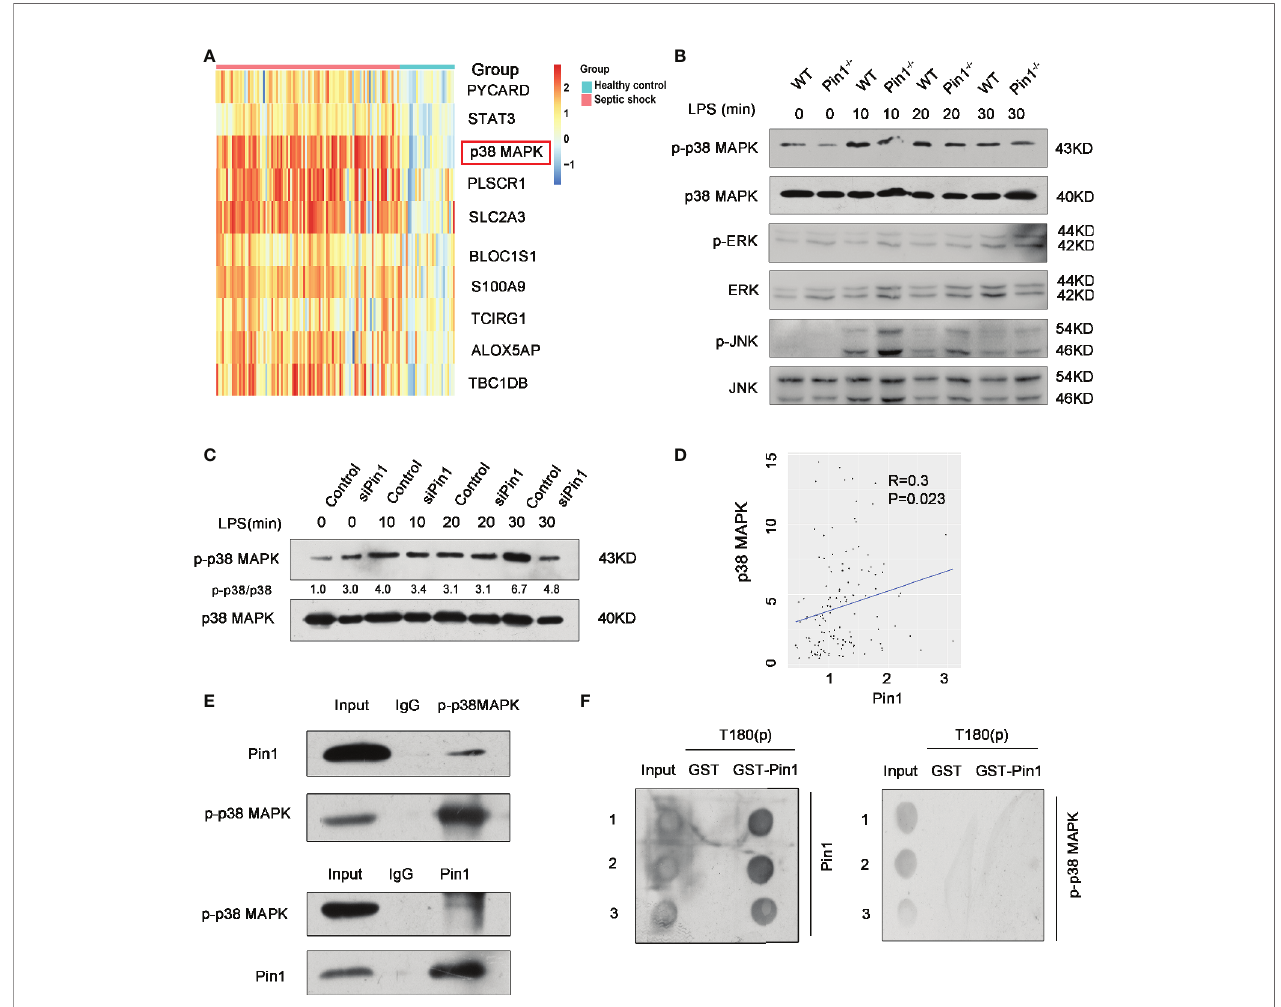
FIGURE 5 | Pin1 regulates NLRP3 in fl ammasome expression by promoting phosphorylation of p38 MAPK pathway. (A) Analysis of one published septic shock clinical data set (GSE26440), revealed that p38 MAPK expression is upregulated in septic shock. (B) Immunoblot analysis for activation of p38 MAPK, ERK, and JNK in cell lysates from WT and Pin1 -/- bone marrow-derived macrophages (BMDMs) and stimulated with LPS (500 ng/ml) for 0, 10, 20, and 30 min. (C) Immunoblot analysis for activation of p38 MAPK in RAW 264.7 cells transfected with control siRNA or siPin1 for 0, 10, 20, and 30 min. (D) Correlation analysis between Pin1 and p38 MAPK in GSE26440. (E) BMDMs were collected to perform co-immunoprecipitation with p-p38 MAPK or Pin1. (F) Dot blot analysis for detecting the interaction between Pin1 and p38 phosphopeptide (T180(P)). The numbers 1,2,3 represent three